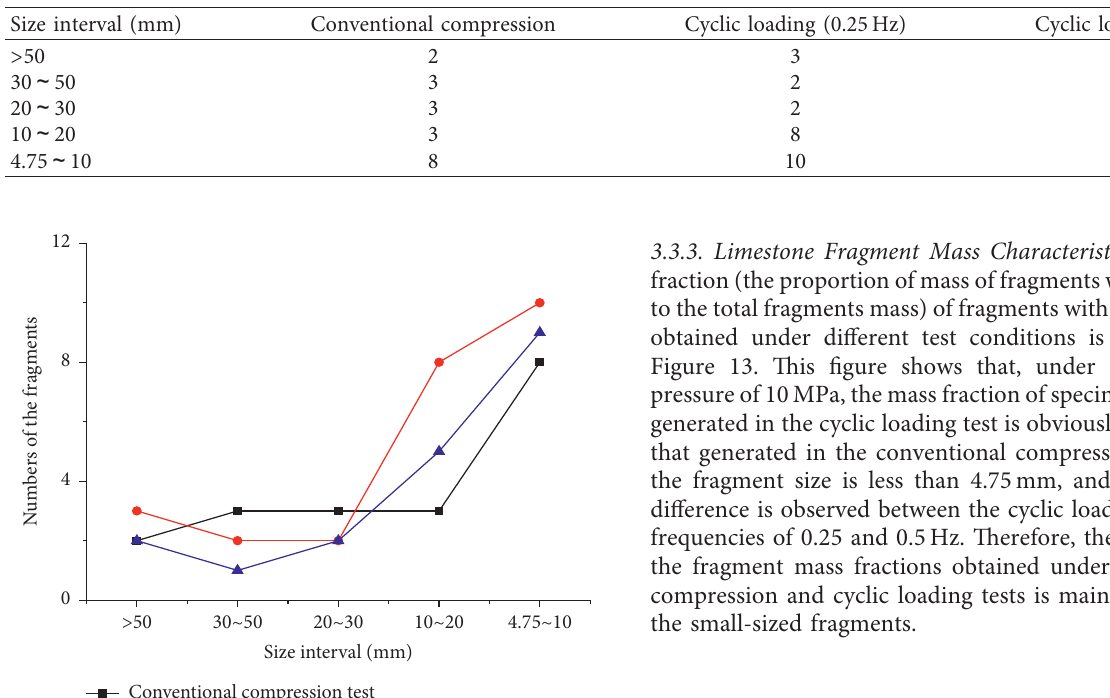
Figure 11: Sieving results of limestone fragments obtained under a confining pressure of 10MPa. (a) Conventional compression test. (b) Cyclic loading test with a frequency of 0.25Hz. (c) Cyclic loading test with a frequency of 0.5Hz. Table 5: Quantity distribution of limestone specimen fragments.